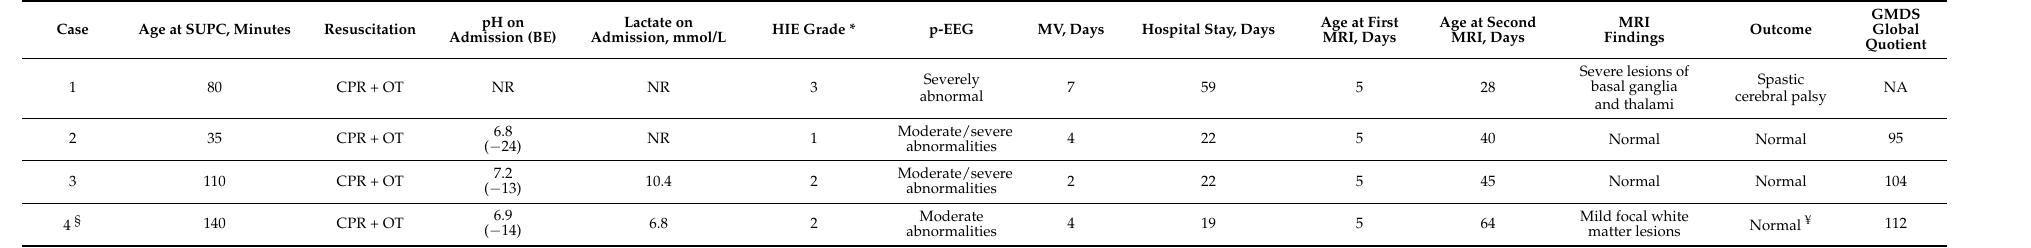
Table 2. Clinical findings and 24-month follow-up data of infants who underwent